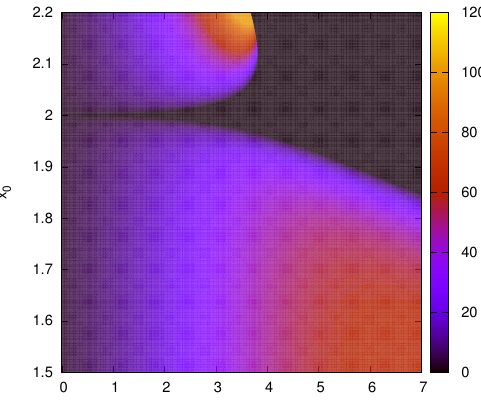
Figure 2. Basin of attraction of the fixed point x = 2 for α ∈ ( 0,7 ) and initial conditions x 0 ∈ [ 1.5,2.2 ] . Colors denotes the number of iterations within a tolerance of 10 − 3